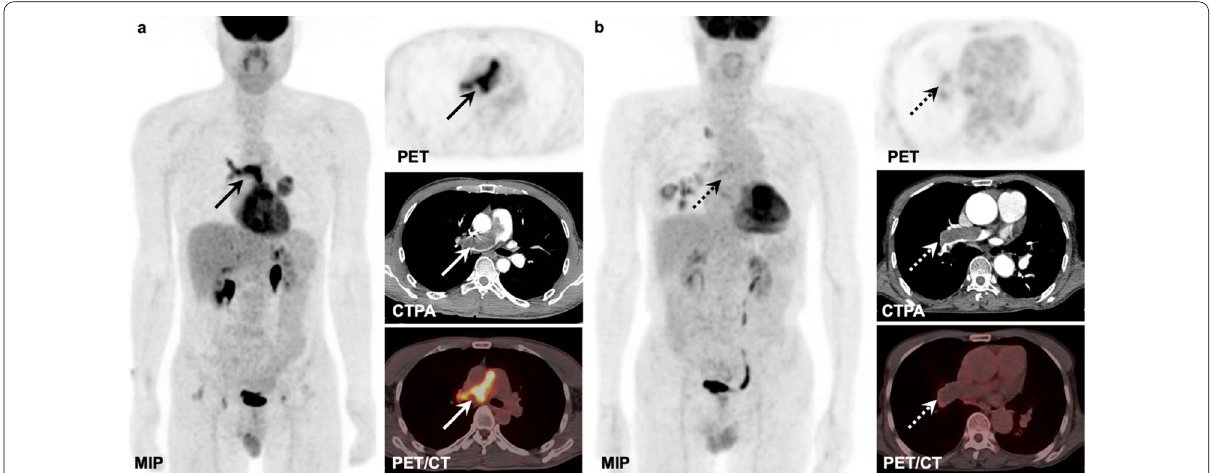
Fig. 1 a PAS in a 52-year-old man involving PT and RPA (solid arrows) with intense FDG uptake (SUVmax: 10.7) on the MIP, axial PET, and fused PET/ CT images, and filling defect on the CTPA image. b PTE in a 64-year-old man involving RPA (dotted arrows) with mild FDG uptake (SUVmax: 1.1) on the MIP, axial PET, and fused PET/CT images, and filling defect on the CTPA image